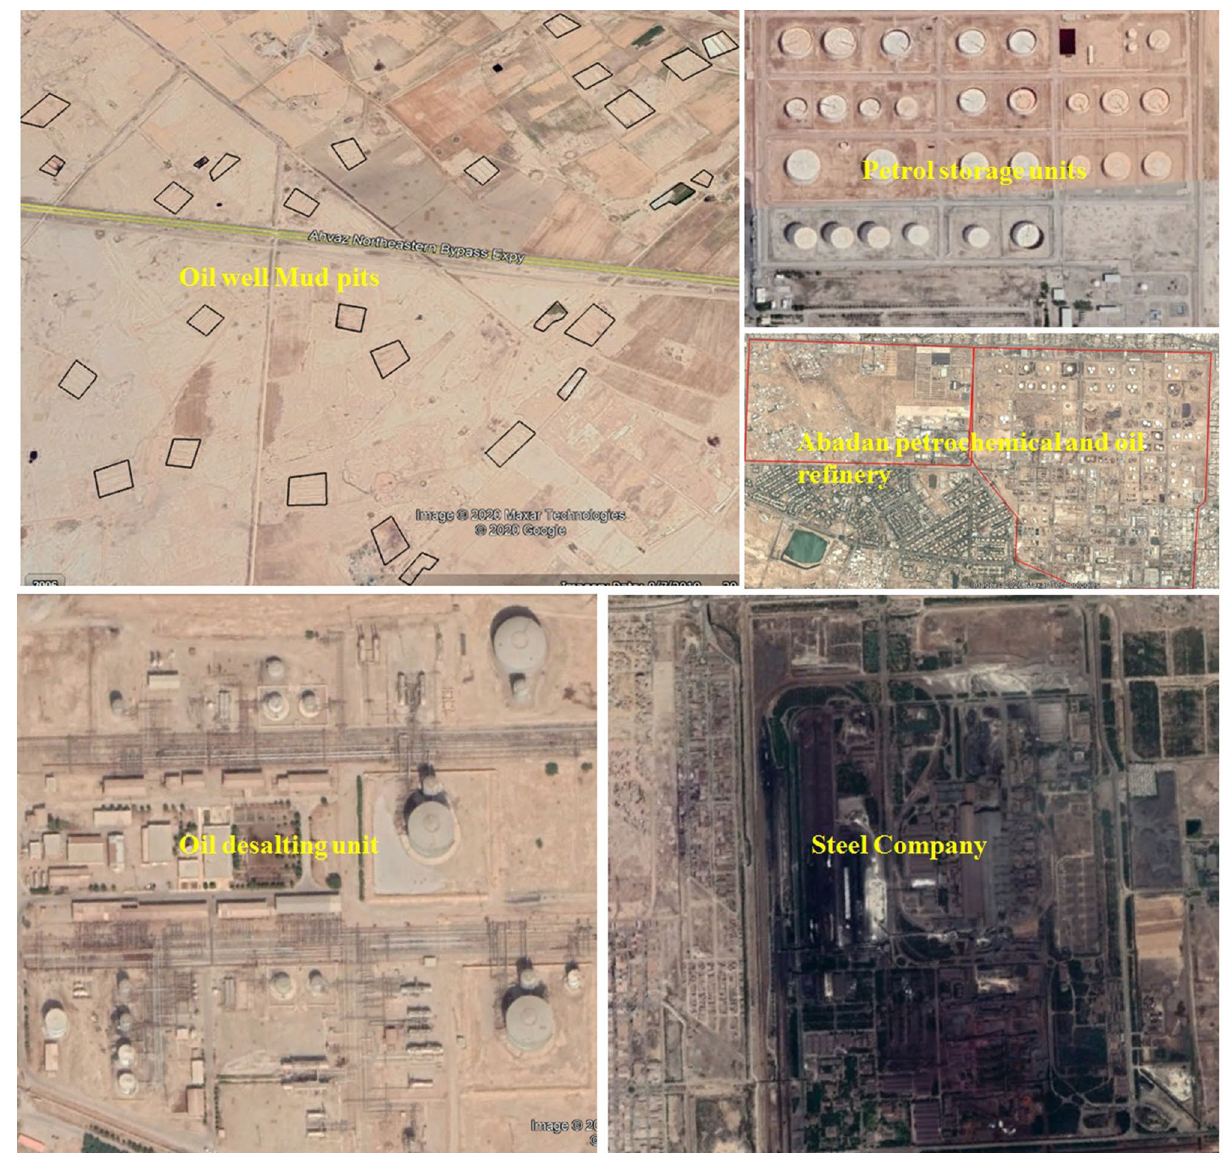
Figure 2. Satellite image of some oil related steel industries in Khuzestan plain, the image was made by ArcGIS10.2, background from Google Earth (Image: Google,